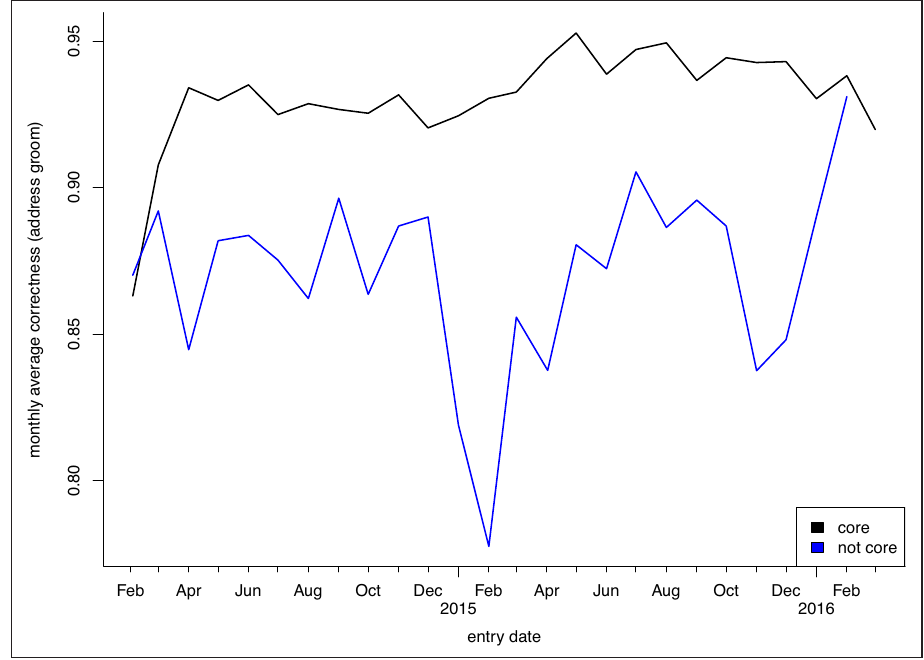
Figure 9: Accuracy over time (monthly average accuracy measured by the optimal string alignment (OSA, see page 11) string distance metric between the volunteers’ transcription and the final correction of the groom’s address), by vol- unteer group (core: >1,000 scans; not core: ≤ 1,000 scans).